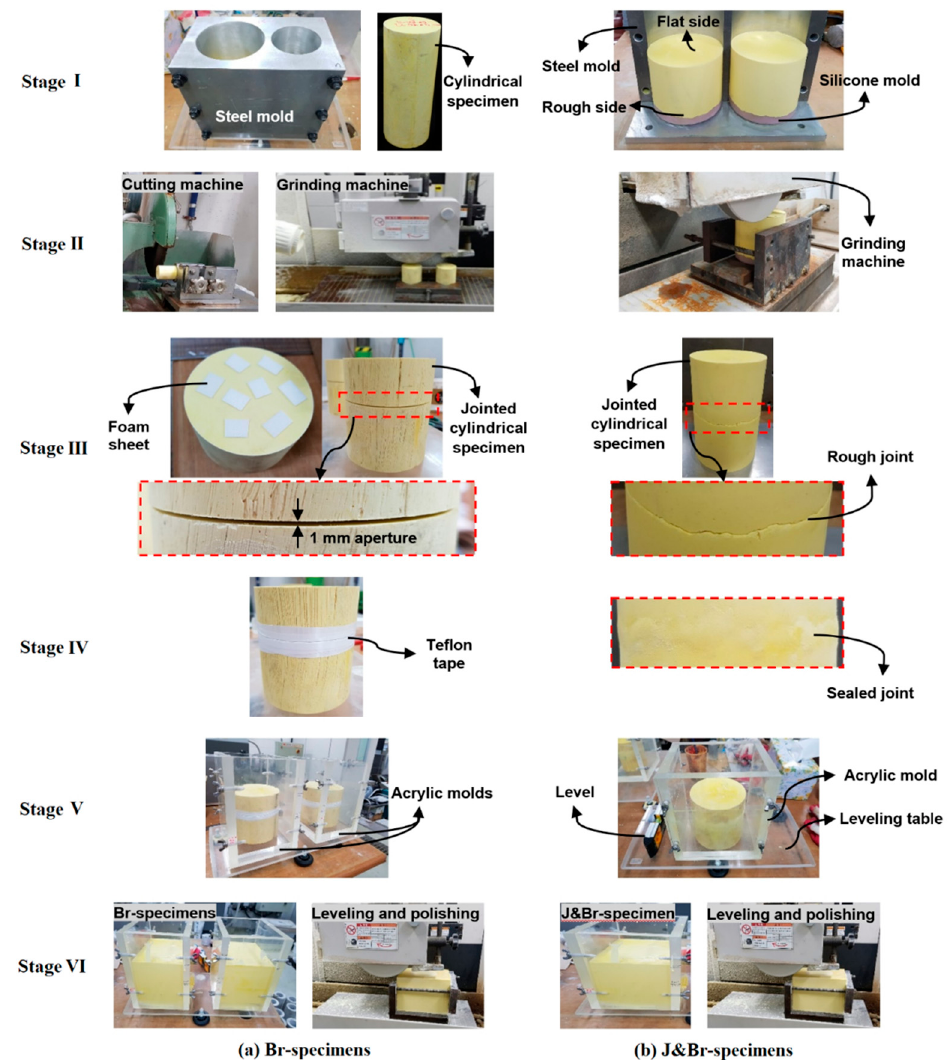
Figure 4. Step-by-step preparation process of ( a ) Br specimens and ( b ) J&Br specimens. 2.4.3. Specimens Containing a Single Non-Persistent Rough Joint (J&Br specimens) Twenty-seven rectangular cuboid plaster specimens (length: 150 mm, width: 115 mm, height: 130 mm) embedding a single non-persistent rough joint were cast to investigate the simultaneous shear behavior of joint and rock bridge. The specimen preparation process of J&Br specimens is quite similar to that applied for the Br specimens and consists of the following stages (Figure 4b).